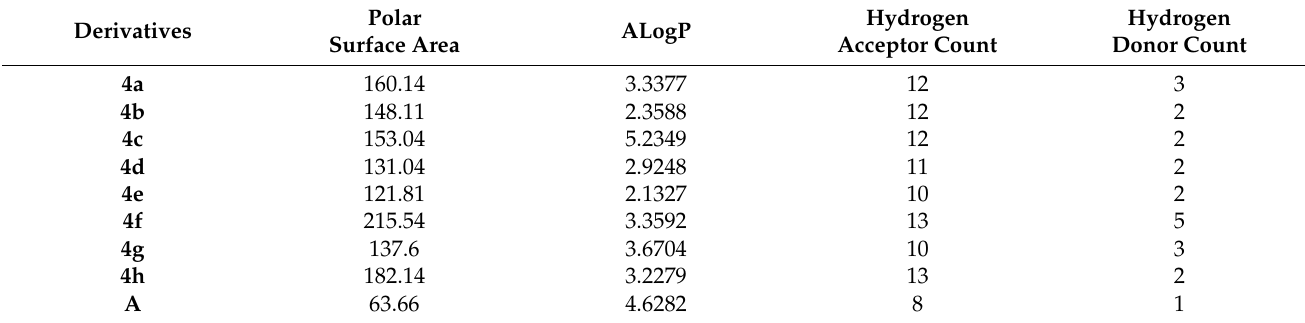
Table 1. Selected parameters describing the properties of potentially active